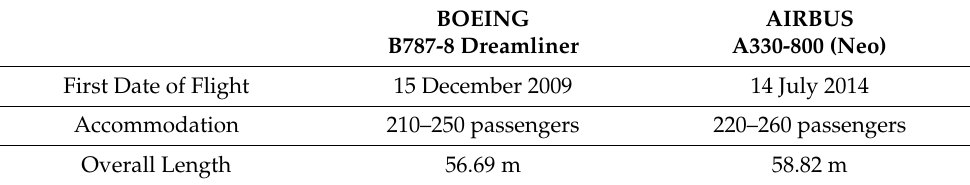
Table 3. Boeing and Airbus aircraft model comparison; B787-8 Dreamliner vs.